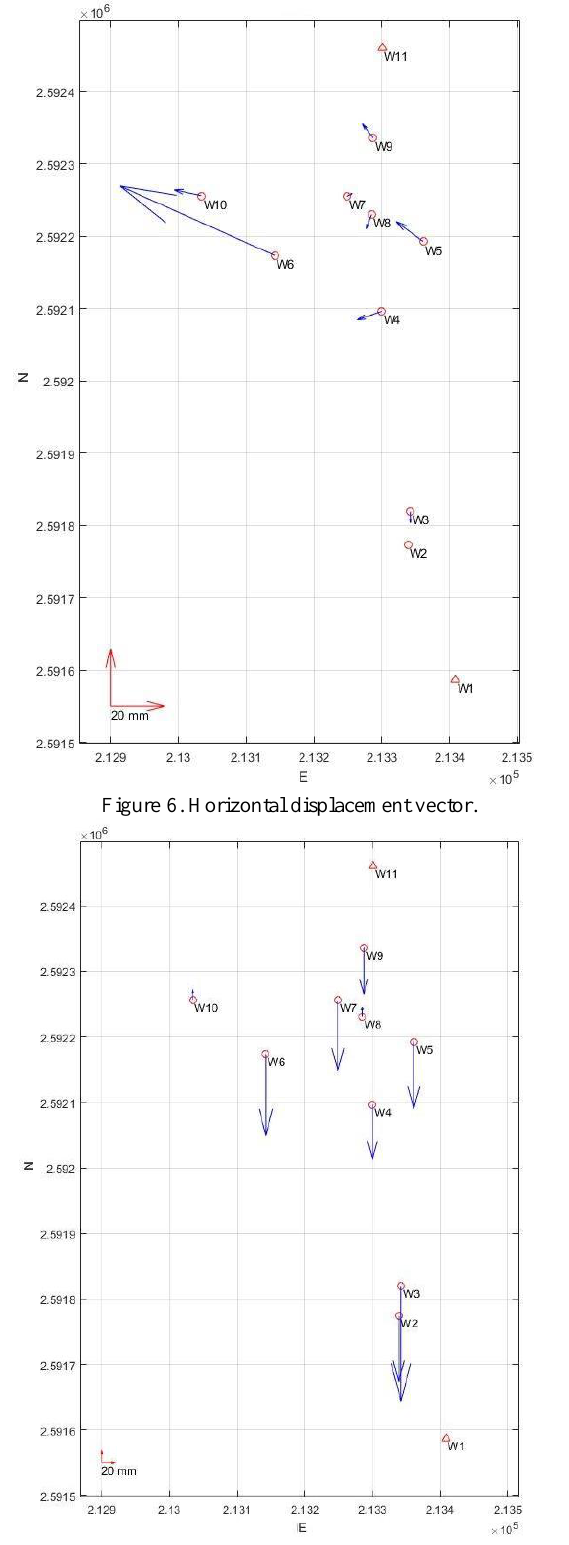
Figure 7. Vertical displacement